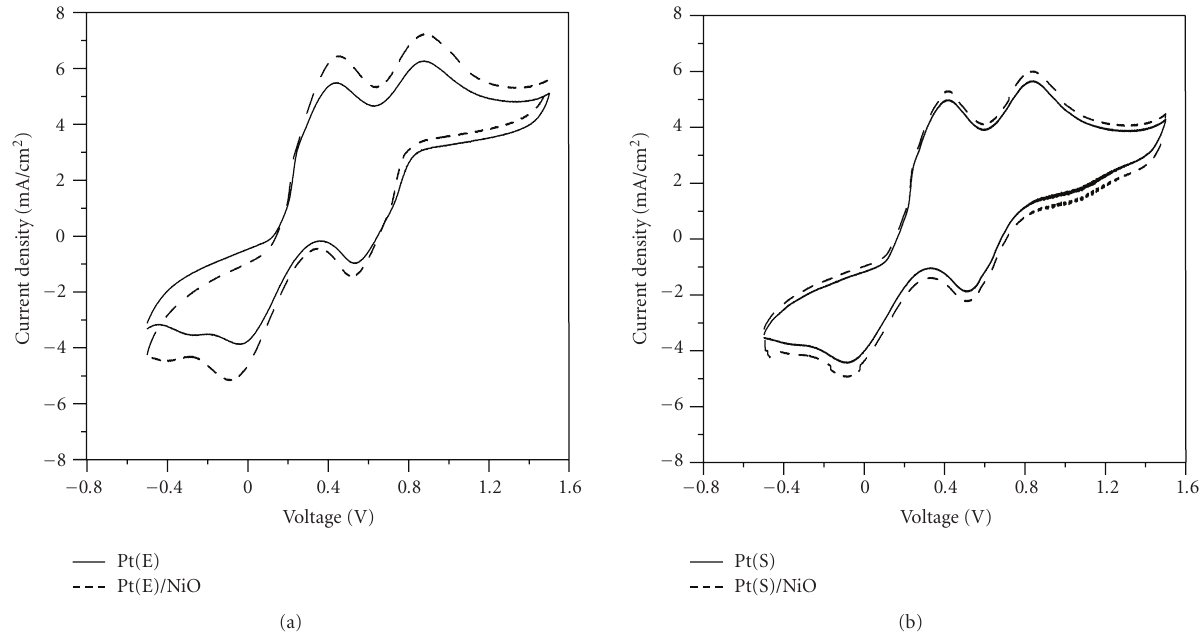
Figure 6: Cyclic voltammograms (CVs) of counter electrodes of Pt(E), Pt(S), Pt(E)/NiO, and